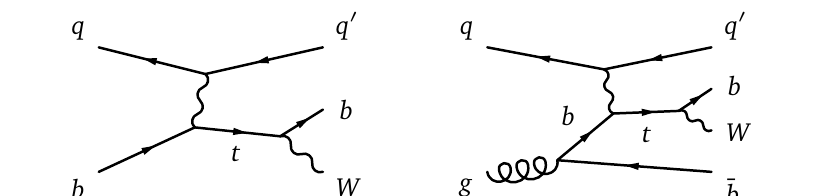
Figure 2: Example Feynman diagrams for the single top contribution to the W + jets